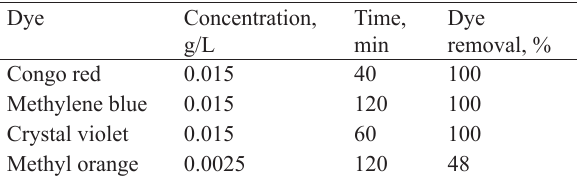
Table 2 Percentage removal of dyes